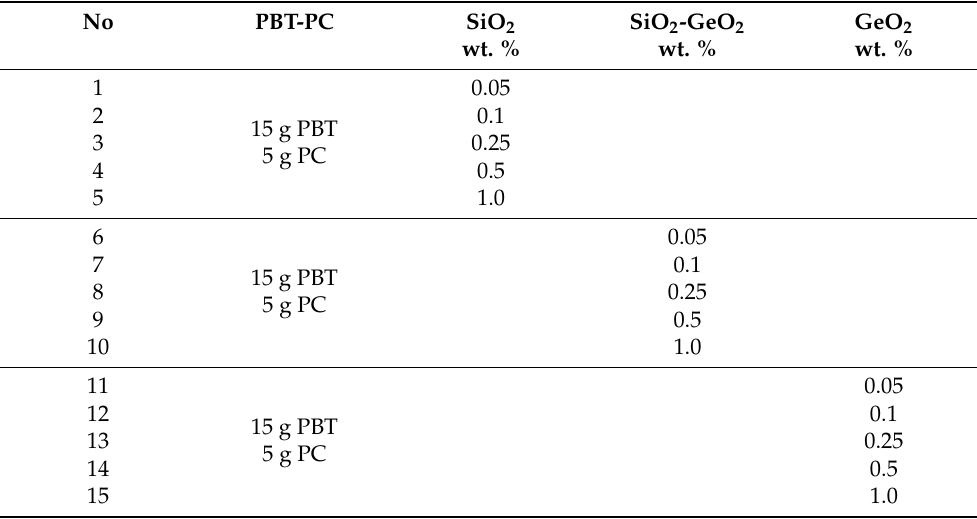
Table 5. Plan of PBT-PC-Glass